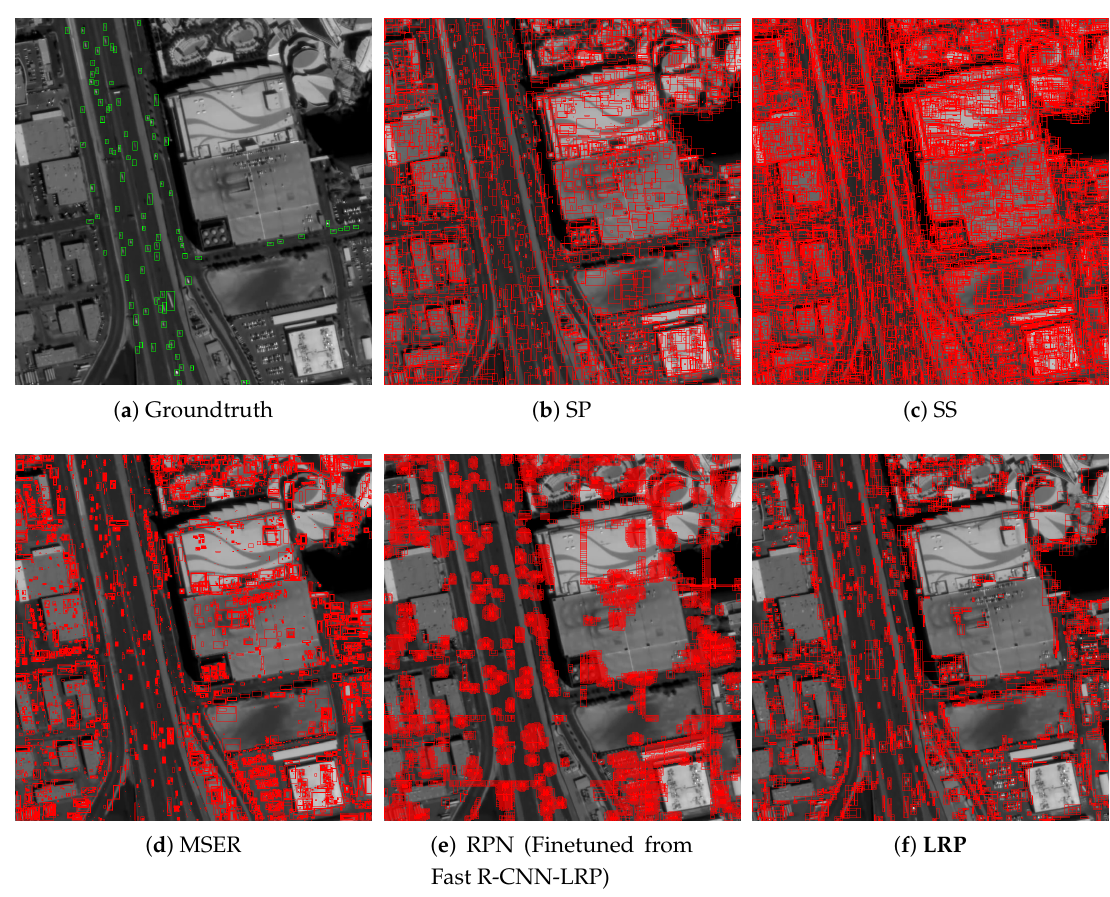
Figure 8. Visualization on generated region proposals by different approaches on SkySat-Las Vegas Dataset.